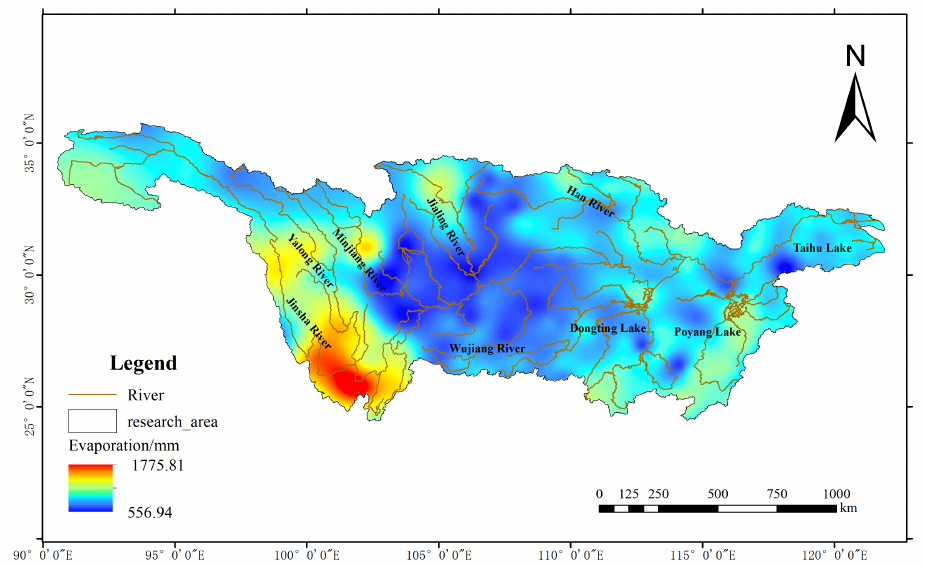
Figure 15. The spatial distribution of the reconstructed dataset for the E601 pan of the Yangtze River